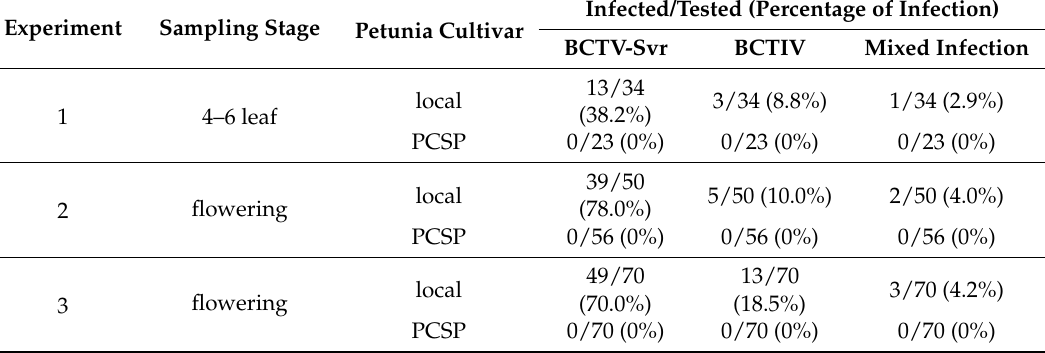
Table 2. PCR analysis of petunia seedlings developed from seeds under insect-free conditions of two varieties (a local cultivar and Purple Classic Spreading Petunia, PCSP) for BCTV-Svr and BCTIV infection in three different experiments in two sampling (either 4–6 leaf or flowering)